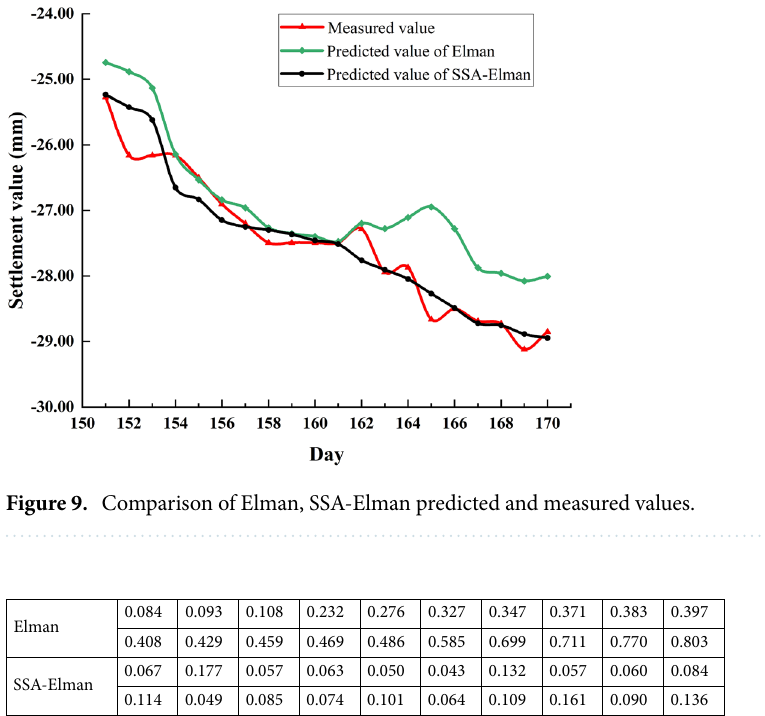
Table 4. Predicted value variance for Elman and SSA-Elman.